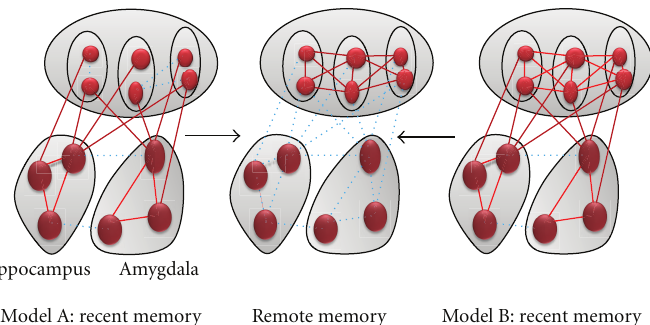
Figure 1: Interplay of the cortex and hippocampus/amygdala in fear memory. There are two major hypotheses related to the brain network involved in fear memory. Depending on the di ff erent types of conditioning protocols, it is likely that both mechanisms may take place. In model A, early fear memory is formed within the hippocampus and/or amygdala. At some time point after learning (e.g., during sleep), some of this information is replayed and transferred into the cortical synapses. After the formation of remote memory in the cortex, early synaptic changes are unlikely important. The exact synaptic and molecular mechanisms for the replaying remain to be investigated or proved. According to this model, the cortical activity is not required for the formation of early fear memory. In model B, early synaptic potentiation related to fear conditioning happens at synapses located in all three major areas, including the hippocampus, amygdale, and cortex. The interconnections among these three areas may be further enforced after the formation of early memory. Similar to model A, late or remote memory is mainly stored in the cortical